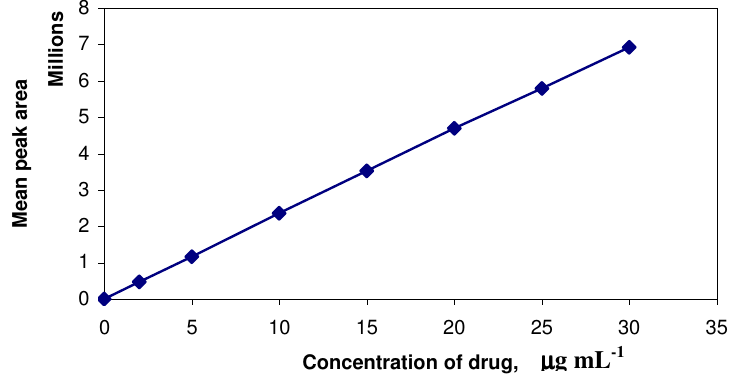
Figure 3. Linearity curve